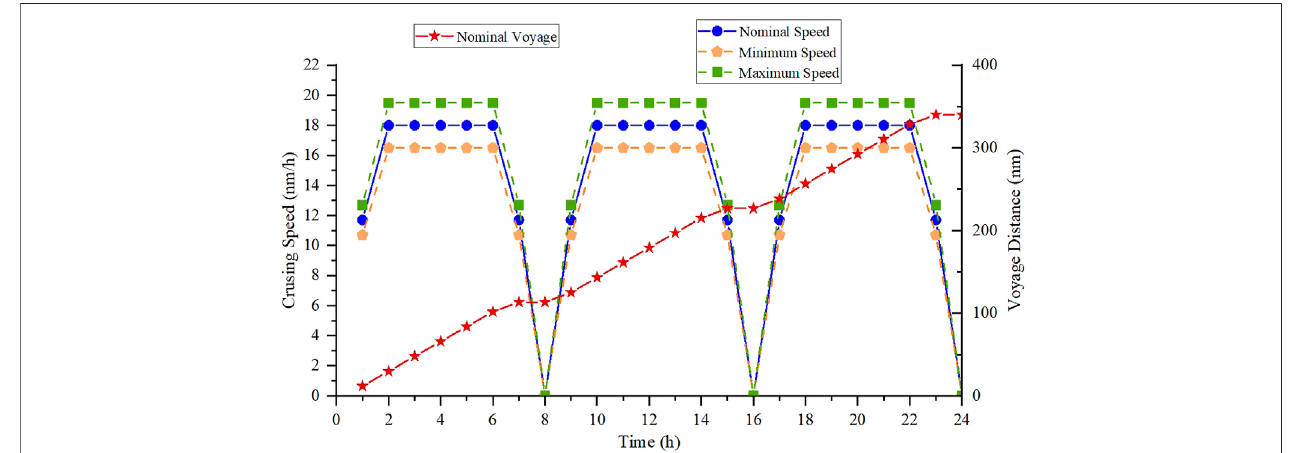
FIGURE 3 | Ship voyage pattern.